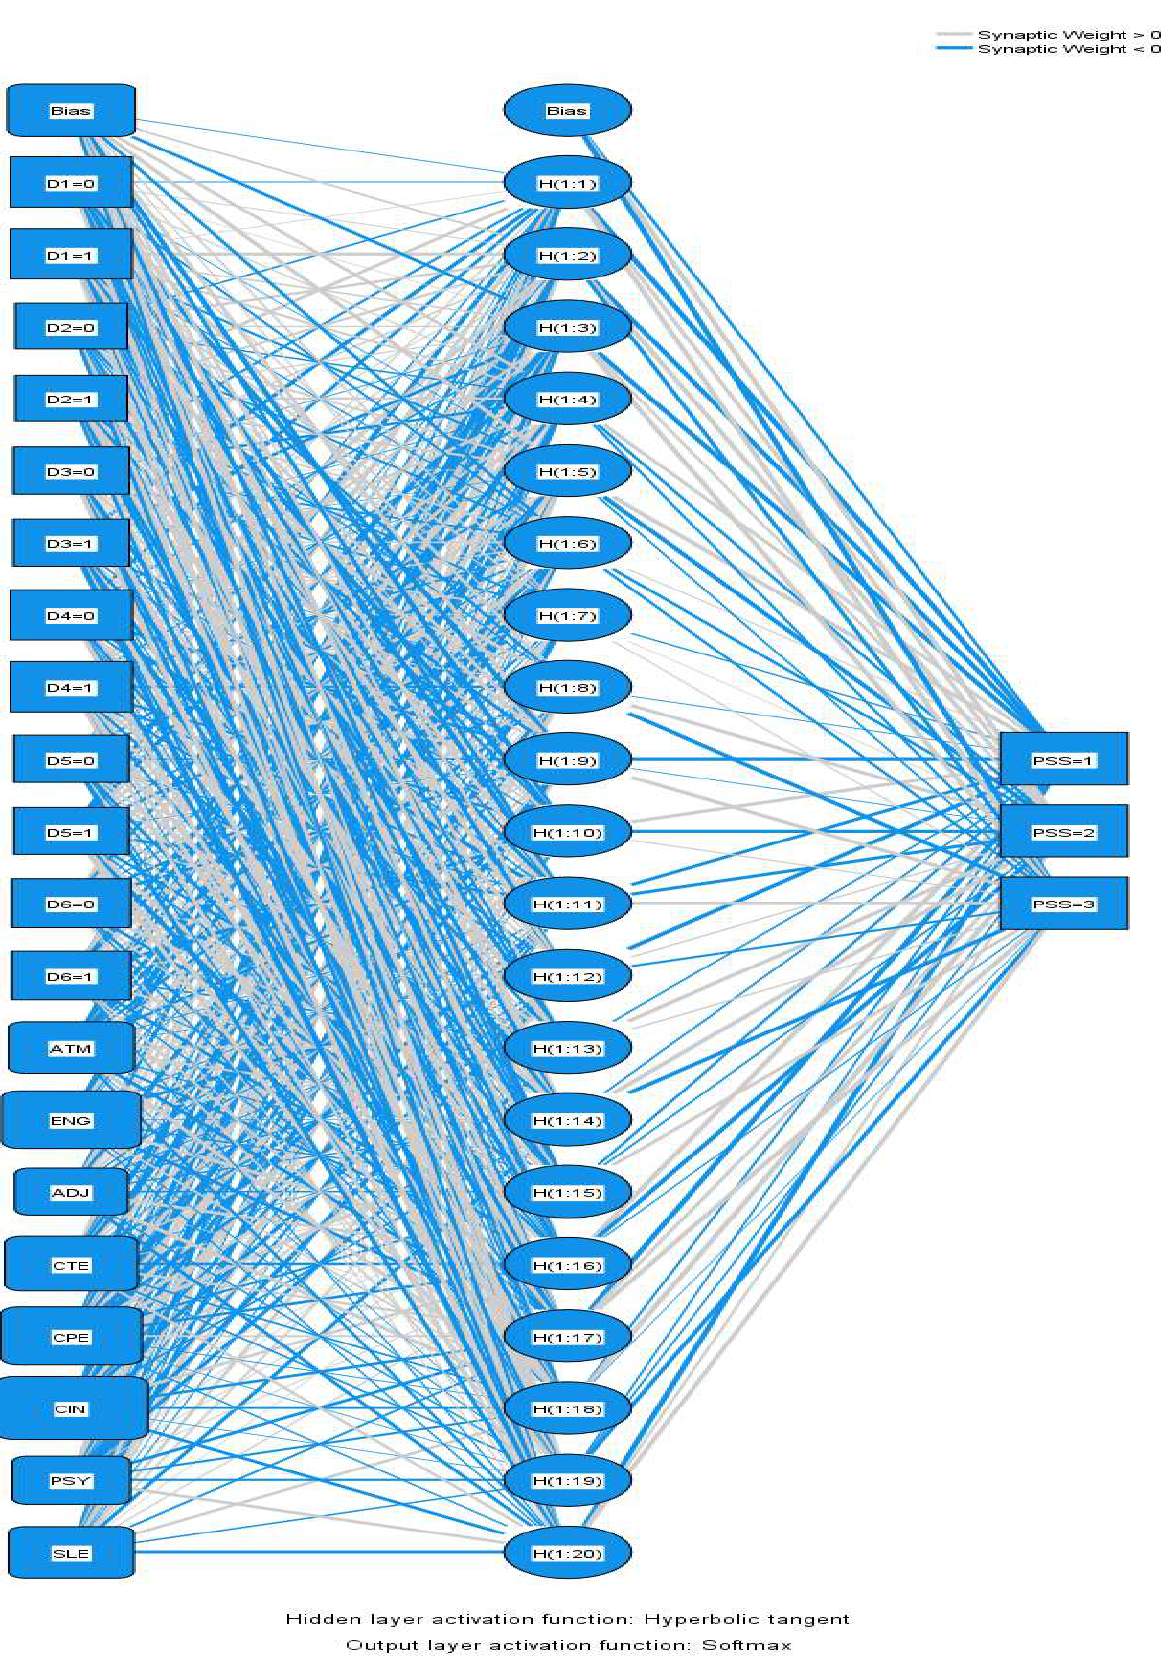
Figure A2. ANN2 topology for cycle time with multilayered perceptron.